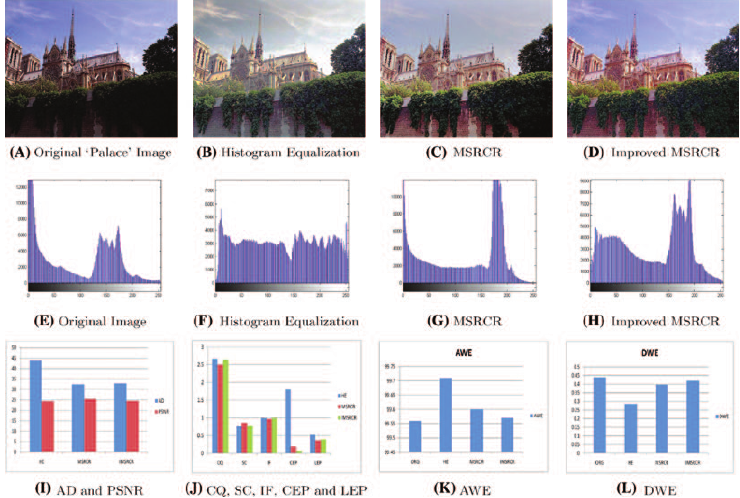
Figure 1. (Top) Image Enhancement Methods. (Middle) Histogram Plots: x -axis, Intensity Levels Ranging from 0 to 255; y -axis, Total Number of Pixels. (Bottom) Conventional Metrics and Proposed AWE and DWE Metrics. The “Palace” Image has been Downloaded from http://visl.technion.ac.il/1999/99-07/www/.